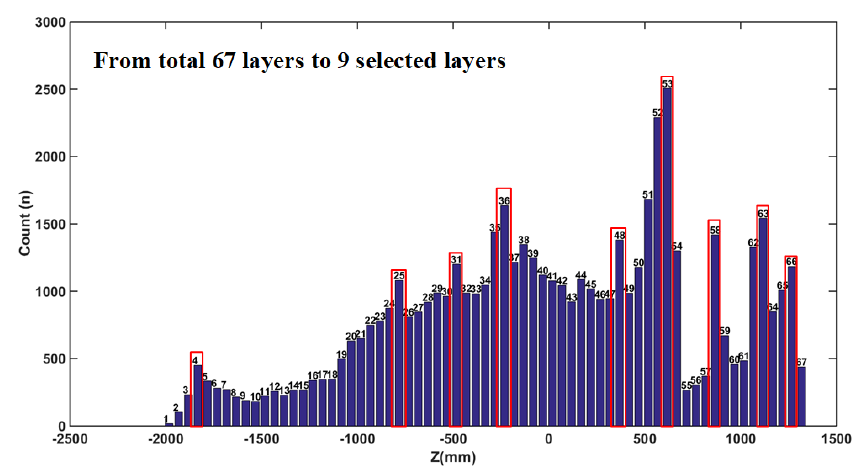
Figure 10. The histogram of boundary points along the upward direction: The selected local maximum layers are bounded by the red rectangles (Figure 7b shows the total 67 layers).